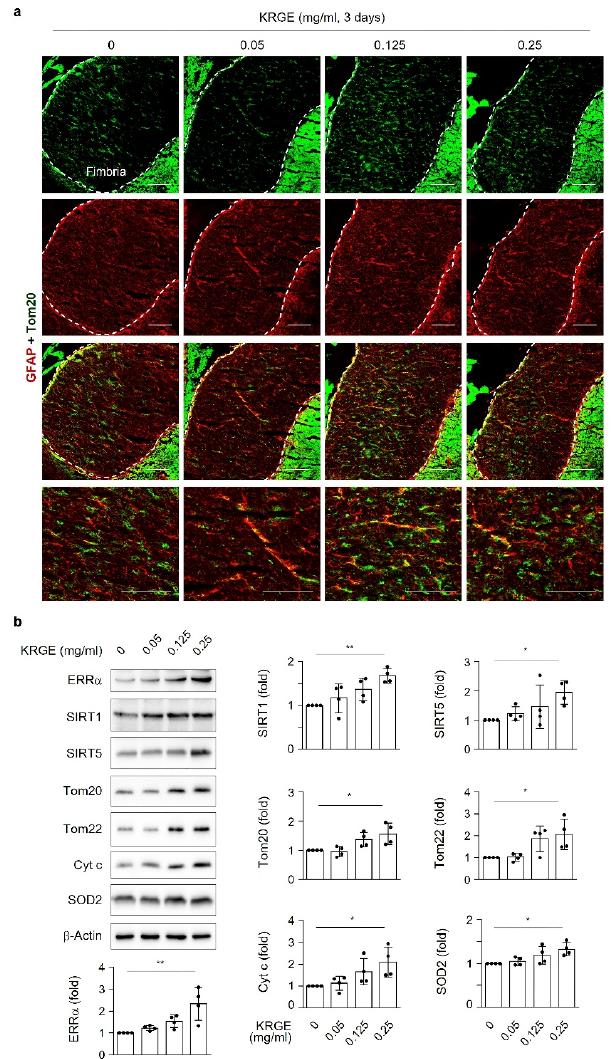
Figure 8. KRGE administration upregulated mitochondrial functional proteins. ( a ) Representative images of Tom20- (green) and GFAP-stained (red) mouse brains following water or KRGE admin- istration for 3 days ( n = 3 per group). Dotted lines indicate the fimbria region of the hippocampus. Co-localized staining can be observed as yellow color in the fimbria region. Scale bars = 100 µ m. ( b ) The expression levels of target proteins were determined in brain tissues using Western blot analysis ( n = 4 per group). * p < 0.05; ** p <